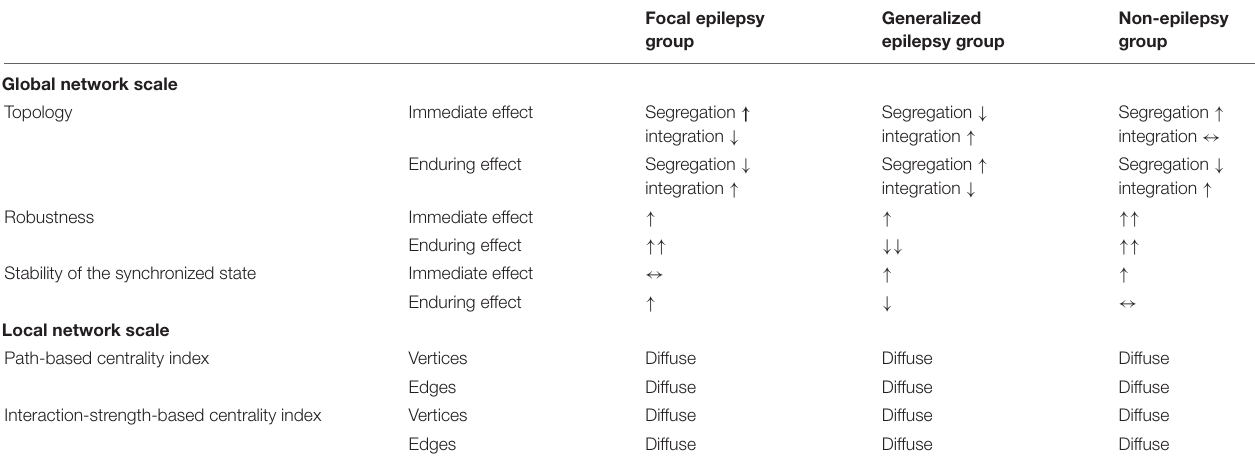
TABLE 1 | Synopsis of taVNS-induced immediate and enduring modifications of global and local characteristics of weighted fully connected functional brain networks in different epilepsy types.